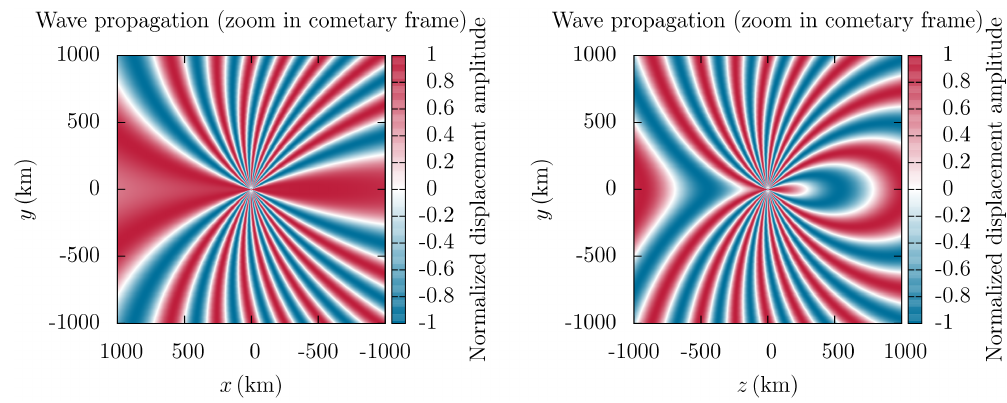
Figure 9. Zoom in Fig. 8.